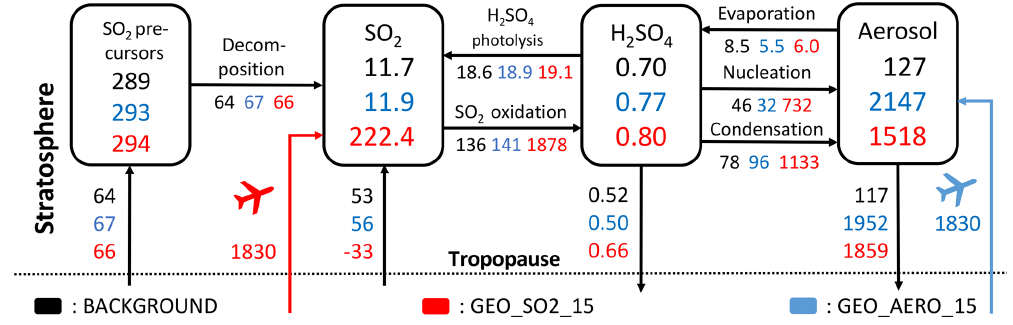
Figure 1. Schematic of the global sulfur cycle for GEO_AERO_15 (blue), GEO_SO2_15 (red) and BACKGROUND (black) averaged over the last 10 years of simulations (see Table 1 for scenario definitions). Net fluxes (positive in the direction of the arrows) are given in GgSyr − 1 and burdens (in boxes) are given in GgS. Species of SO 2 precursors include OCS, DMS, H 2 S, and CS 2 . SO 3 , as an intermediate step between SO 2 and H 2 SO 4 , is modeled but for simplicity is omitted from the